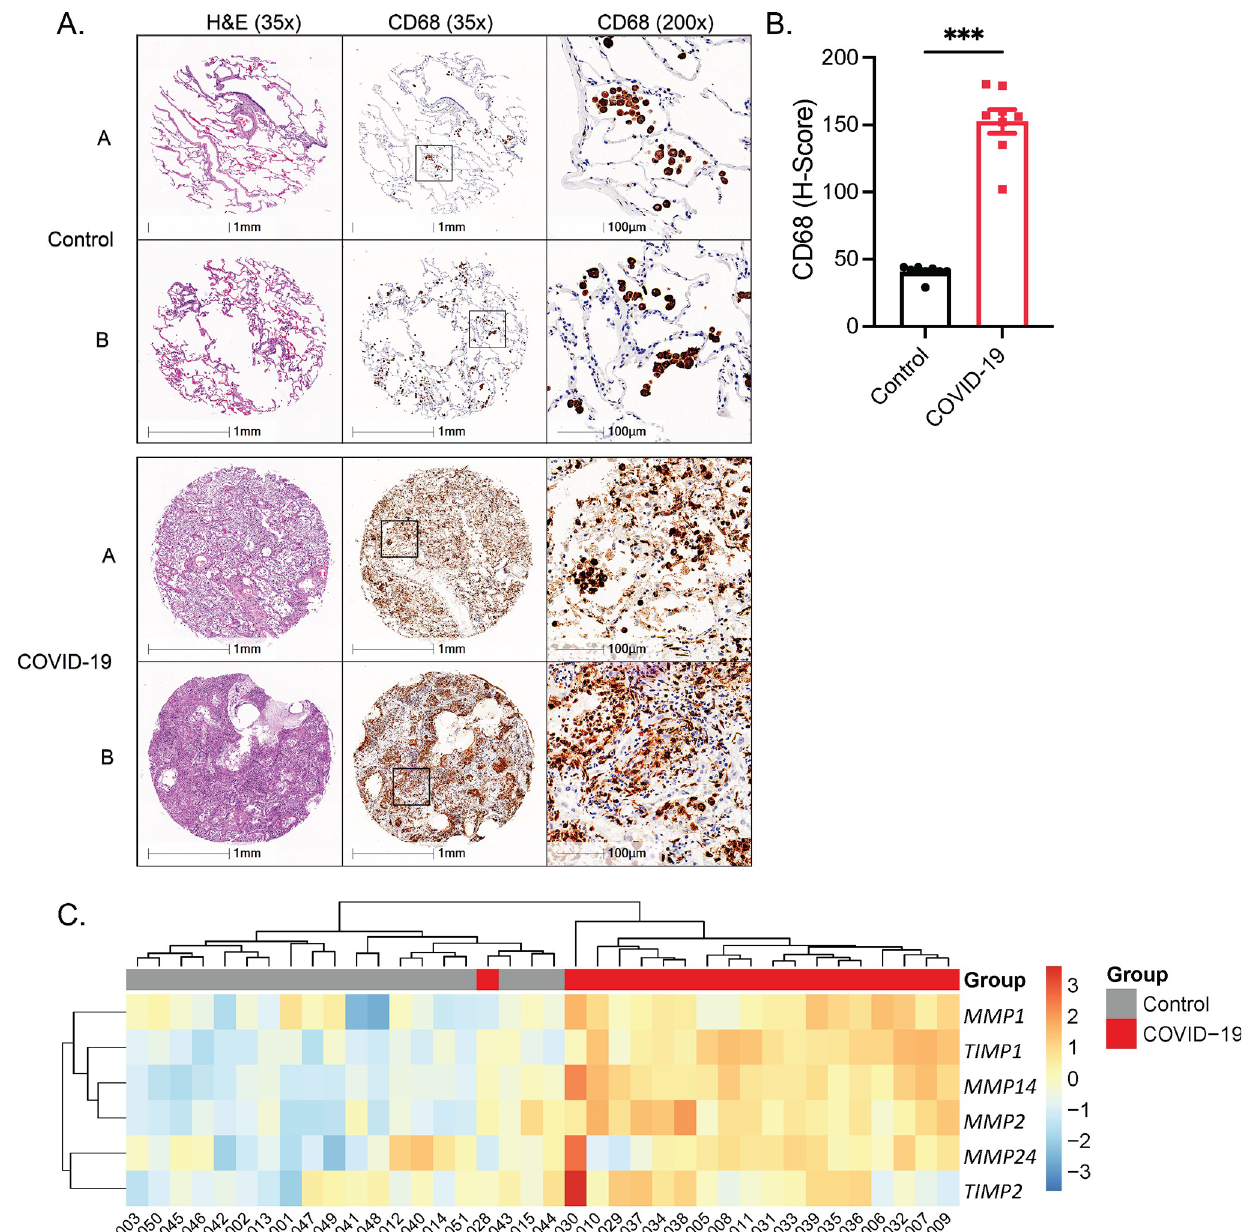
Fig 7. Severe COVID-19 patients display increased macrophage presence and MMP expression. (A) Representative images from tissue microarray of lungs from control and COVID-19 patients. A and B represent two separate patients, stained for H&E and CD68. (B) H-Score, quantifying CD68 between control and COVID-19 patients (n = 8). (C) Heatmap analysing significantly upregulated MMP and TIMP gene expression in the lungs between non and COVID-19 patients. Data in (B), represented as mean ± SEM. ��� p < 0.001 (two-tailed t-test). See also S7